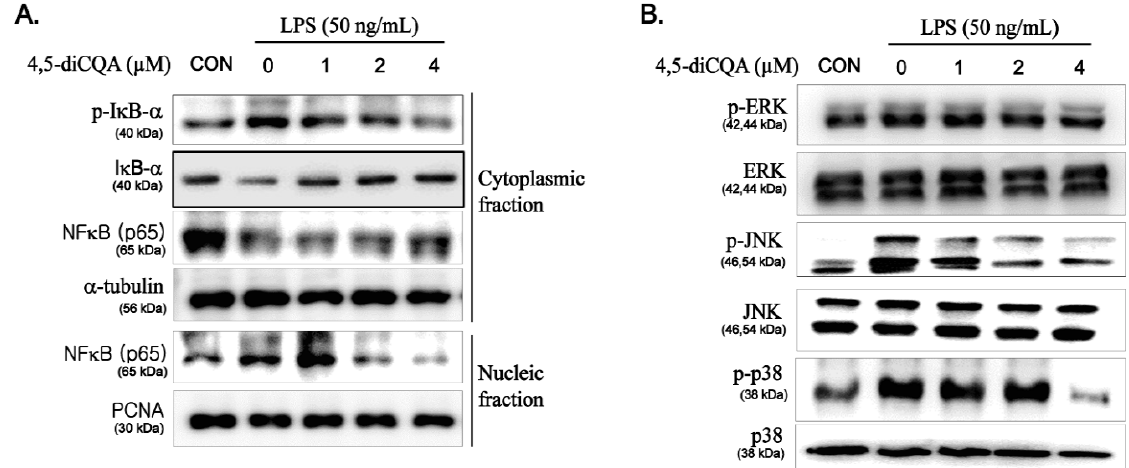
Figure 4. Effects of 4,5-diCQA on LPS-induced activation of NF- κ B and phosphorylation of MAPKs in RAW264.7 cells-stimulated with LPS. Cells were pretreated with 4,5-diCQA (1, 2, and 4 µM) for 1 h, followed by LPS (50 ng/mL) stimulation for 1 h. ( A ) Phosphorylation levels of I κ B- α and NF- κ B p65 translocation to nucleus were determined using Western blot analysis. ( B ) Protein levels of phosphorylation of MAPKs (ERK, JNK, and p38) were determined using Western blot analysis. α -Tubulin and Lamin B1 were used as cytosolic and nuclear internal controls, respectively. CON; control, I κ B- α ; nuclear factor of kappa light polypeptide gene enhancer in B-cells inhibitor, alpha, p65; NF-kappa-B p65 subunit, ERK; extracellular signal-regulated kinase, JNK; c-Jun N-terminal kinase.